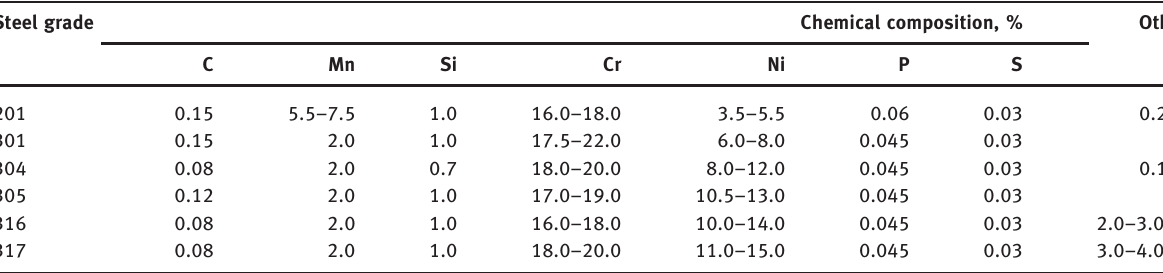
Table 2: Stainless steel grades. Steel grade Chemical composition, %